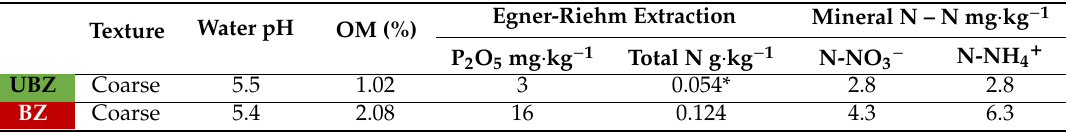
Table 1. Mean values of soil parameters: texture, water pH, soil organic matter (OM) (%), amount of P 2 O 5 (mg · kg − 1 ), total amount of nitrogen (N) (g · kg − 1 ) and amount of mineral nitrogen (mg · N · kg − 1 ), including NO 3 − and NH 4 + . Statistically significant di ff erences, according to t -test with an α = 0.05, are represented by *.